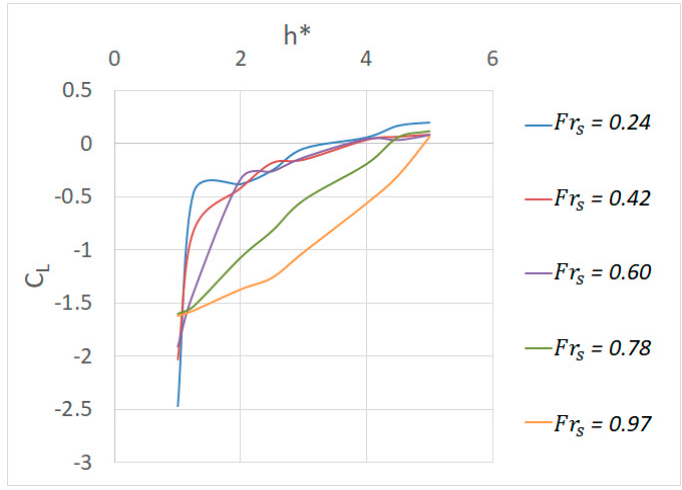
Figure 20. Effect of boundaries (free surface and bottom channel) on the lift coefficient for h u /s = 6.